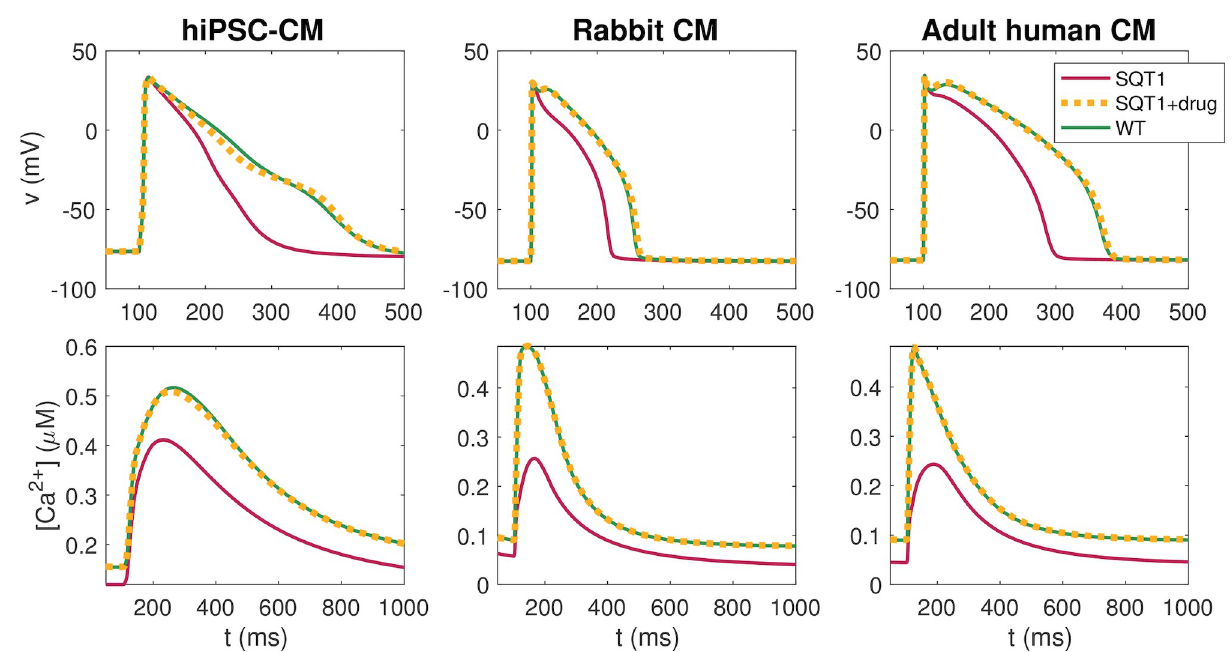
Fig 4. AP and Ca 2+ transient for hiPSC-CMs, rabbit ventricular CMs and adult human ventricular CMs in the wild type case (solid green), in the SQT1 case (solid red), and in the SQT1 case with the optimal combination of two drugs from Fig 3 applied (dotted yellow). Data used in this figure can be found in S1